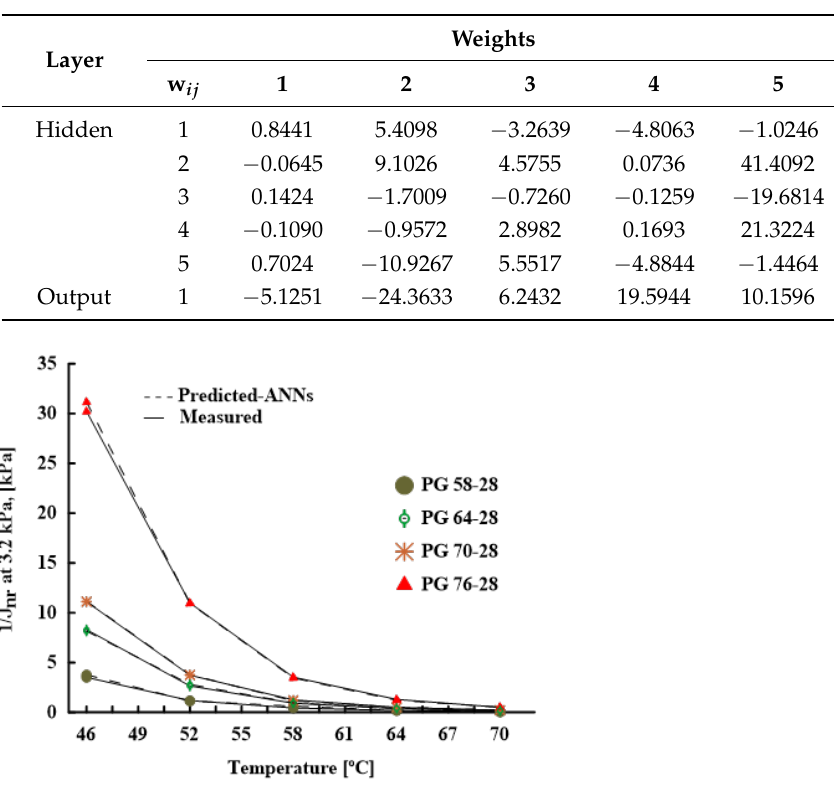
Table 8. Weights and biases for J nr 3.2 model of RTFO binders.